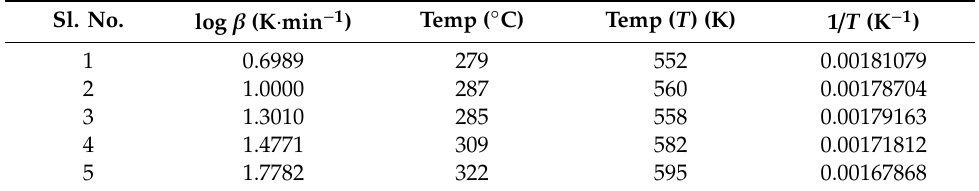
Table 1. The values of abscissa (1 / T ) and ordinate (log β ) for tamarind for the FWO method (at α = 0.2). Sl. No. log β (K · min − 1 ) Temp ( ◦ C) Temp ( T ) (K) 1 / T (K − 1